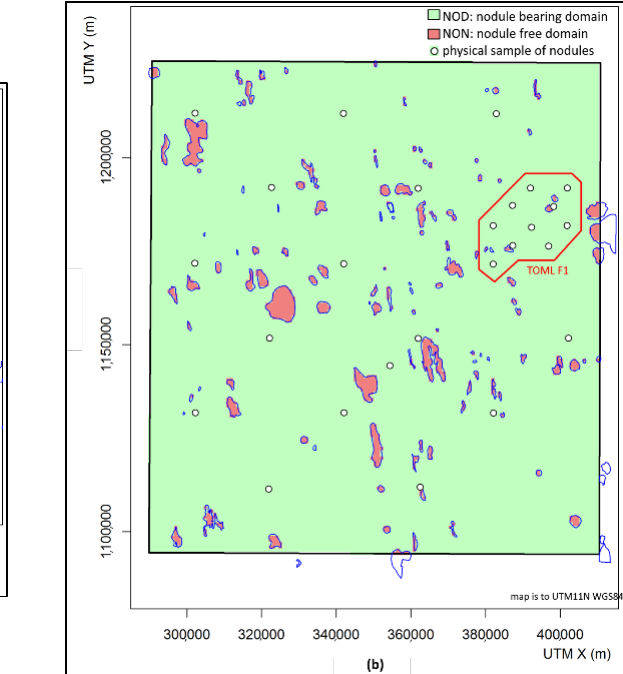
Figure 25. Example domains in TOML mineral resource estimates. ( a ) TOML D and E ( b ) TOML F. Red outlines are areas estimated to an indicated level of confidence; otherwise, these areas were estimated to an inferred level.